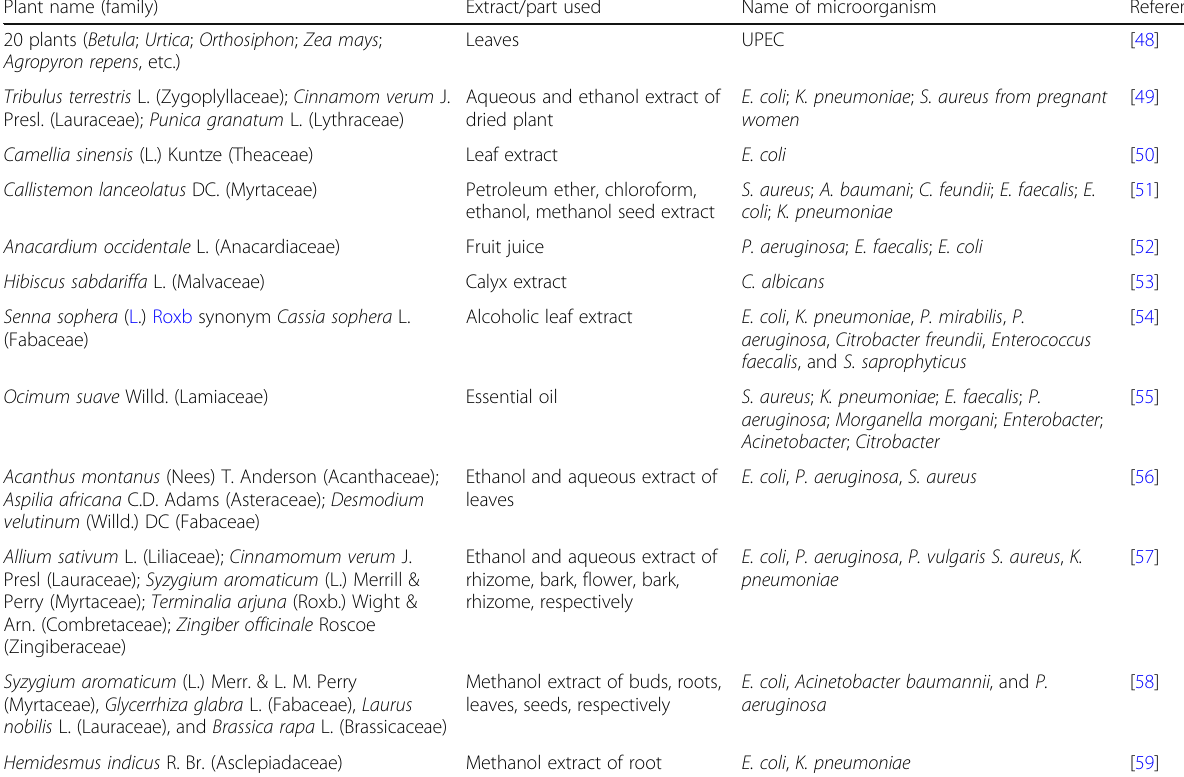
Table 2 List of medicinal plants with anti-uropathogenic potential (Continued) Plant name